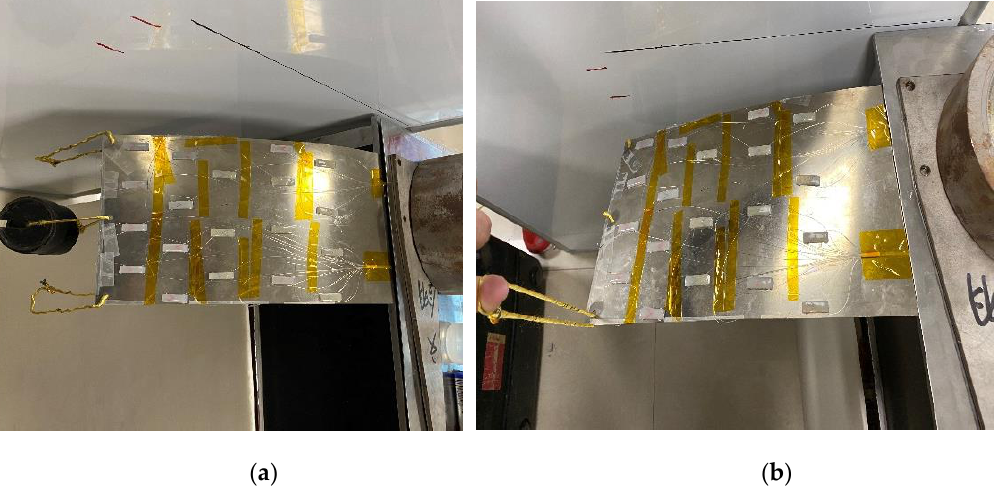
Figure 20. Method of test piece loaded, ( a ) Load in the middle point, ( b ) Load in both side points.